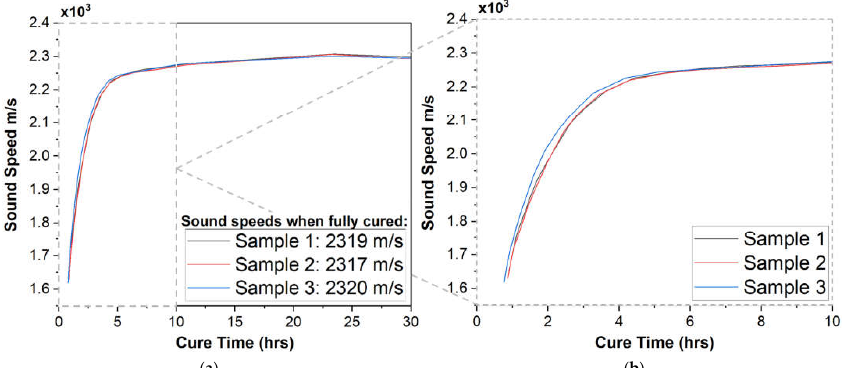
Figure 5. Sound speed with respect to cure time of three adhesive baseline samples during ( a ) the first 30 curing hours; ( b ) the first 10 curing hours located in the dashed rectangle in Figure 5a. After adding 2, 4, and 6 wt.% of IPA to the adhesive samples to simulate a trapped solvent, their sound speed was also evaluated during the curing process. Figure 6 shows how, unlike as previously seen with the baseline samples, the curing process differs for each sample. The sound speed of the sample with no IPA content started converging at a lower cure time, while adding IPA delayed the convergence process. To give some perspective, the curve onset of the sample with 0 wt.% IPA occurred at 1.89 curing hours, while the onset for the samples with 2, 4, and 6 wt.% IPA occurred at 2.77, 3.34, and 3.99 curing hours, respectively. This shows a difference of approximately 2.1 hours between the baseline sample without IPA and the sample containing 6 wt.% IPA. In addition, the sound speeds after four curing days for the samples with 0, 2, 4, and 6 wt.% of IPA were 2322 (±47), 2369 (±49), 2354 (±48), and 2351 (±48) m/s, respectively. This shows how IPA content not only affected the curing mechanics of the adhesive, but also its final sound speed.